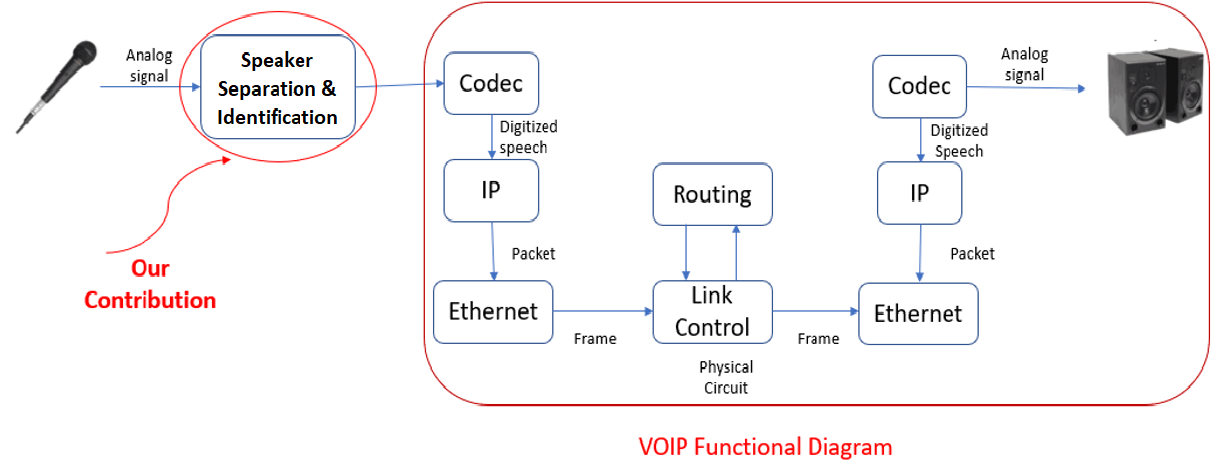
Figure 3. Proposed model integrated with VoIP system.